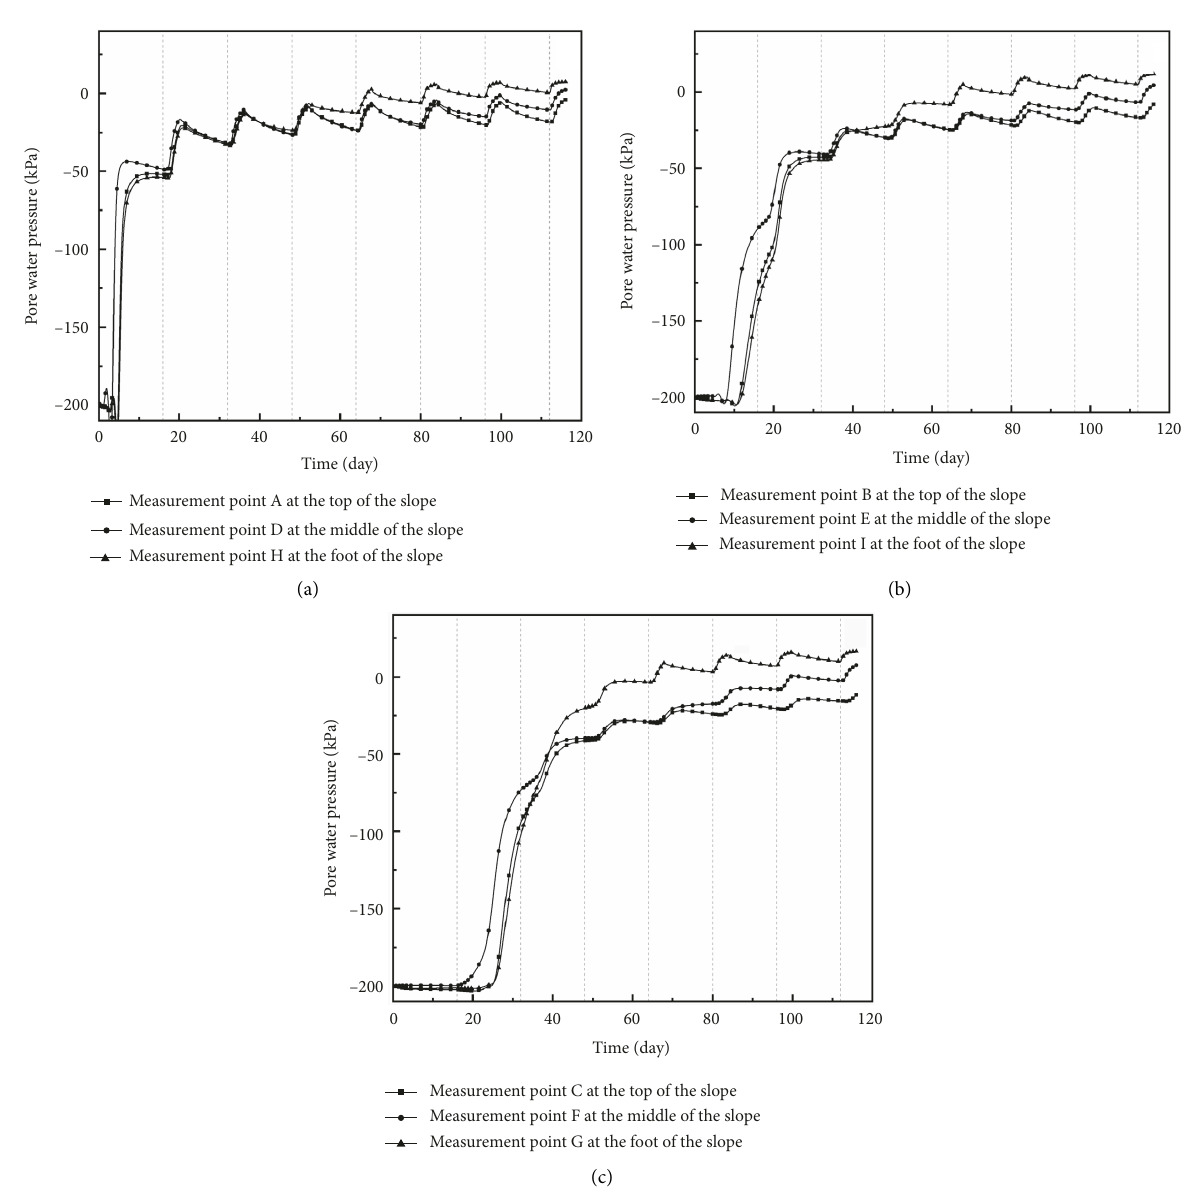
Figure 5: Variation curve of pore water pressure at different depths. (a) Pore water pressure variation curve at 3m depth. (b) Pore water pressure variation curve at 4m depth. (c) Pore water pressure variation curve at 6m